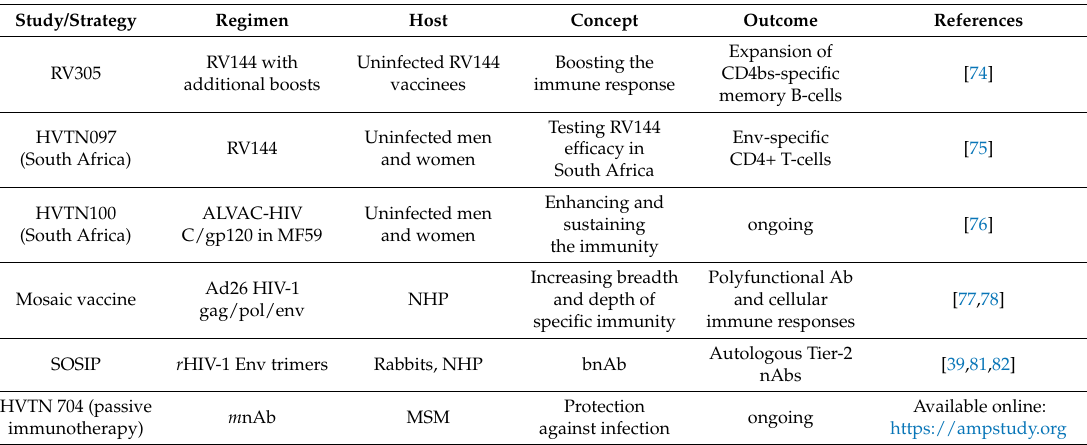
Table 2. Current HIV-1 vaccine